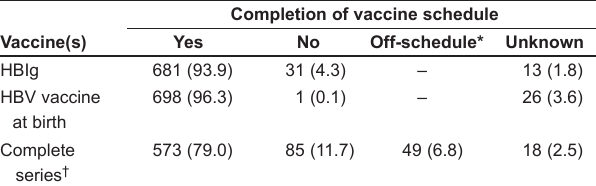
Table 2 Infant vaccine receipt history